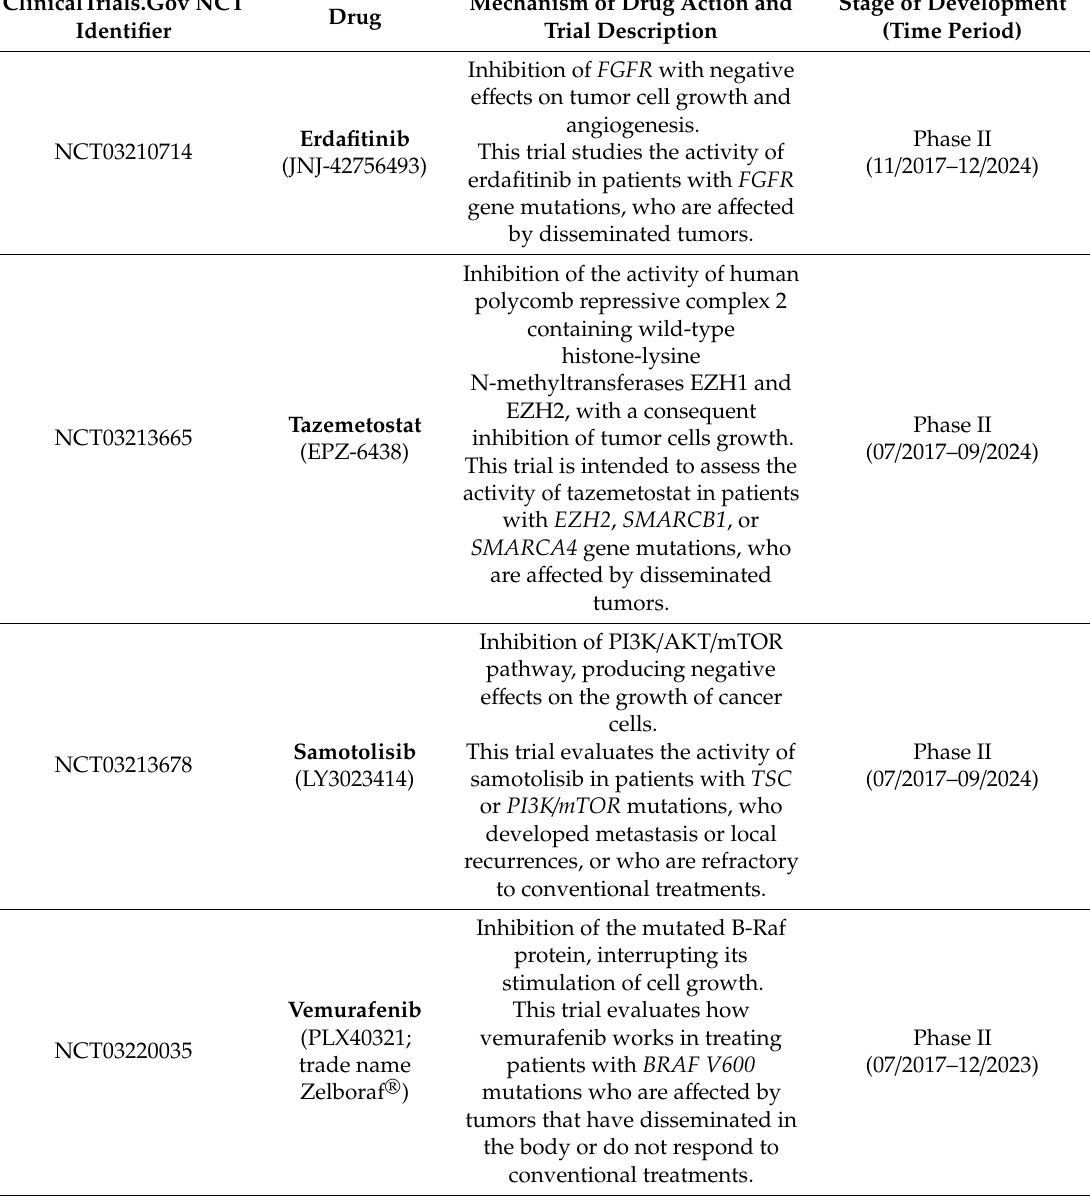
Table 2. List of the pediatric MATCH screening trials that are presently active and recruiting patients with relapsed or refractory advanced solid tumors, including high-grade osteosarcoma. All trials are carried out in the USA. Time period refers to the actual study start date and estimated study completion